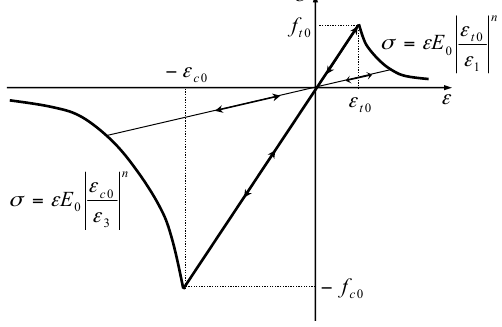
Figure 1. The elastic damage-based constitutive law of elements under uniaxial stress conditions.